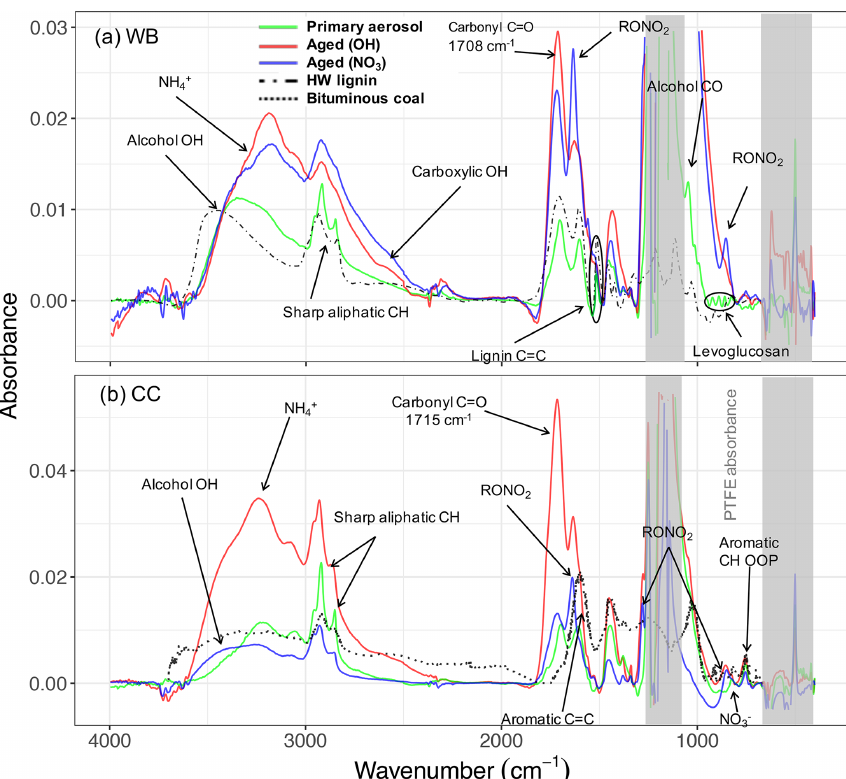
Figure 2. The MIR spectra of primary and aged (with OH and NO 3 ) wood burning (WB) and coal combustion (CC) OAs and their parent compounds: lignin and bituminous coal. The dash-dotted line demonstrates the spectrum of solvent-extracted hardwood (HW) lignin (in KBr pellets) taken from Boeriu et al. (2004). The dotted line shows the spectrum of pulverized bituminous coal taken from Zhang et al.